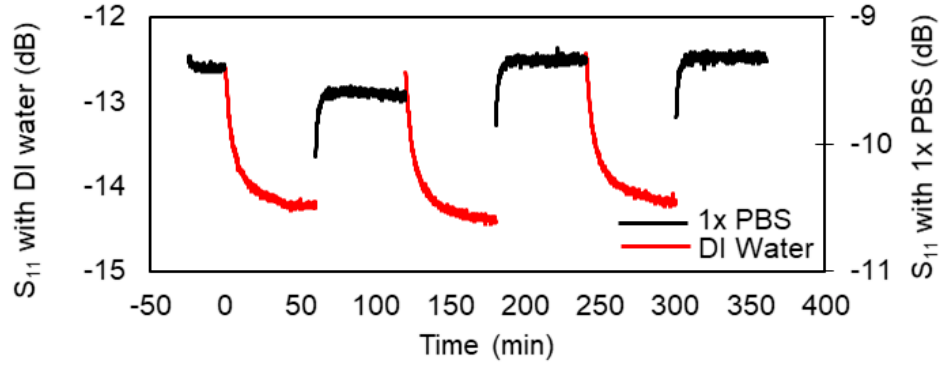
Figure 10. S 11 of microwave resonator/probe with hydrogel at 1.1917 GHz as a function time with different analytes.